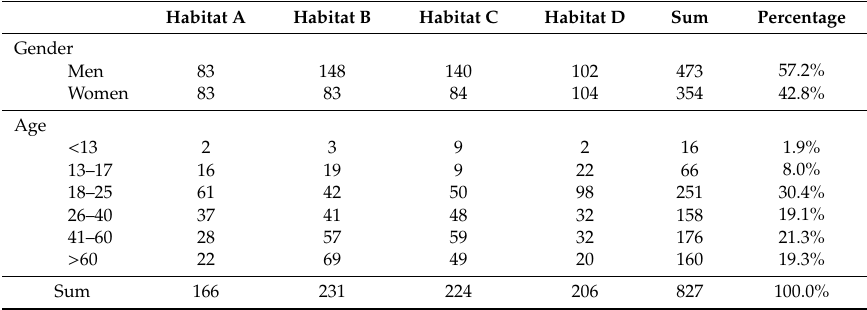
Table 1. The demographic information considering gender and age of the respondents in the PP (People’s